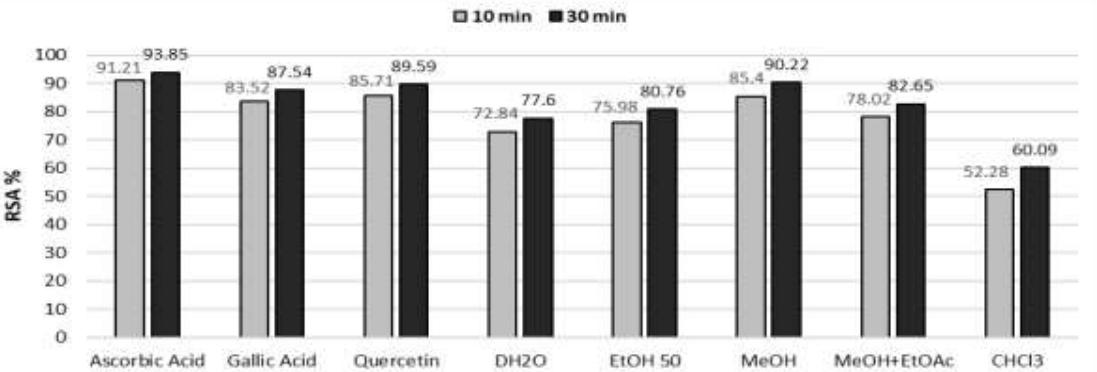
Figure 6. TFC in 1 g of the dried extracts RSA of the extracts DPPH • assay revealed that the methanolic extract was the most effective in free radicals scavenging after 30 min (90.22 %), compared with the other extracts: MeOH: EtOAc (1:1), EtOH 50%, DH 2 O and CHCl 3 , they scavenge 82.65, 80.76, 77.6 and 60.09 % of DPPH • radical, and the scavenging activity after 10 and 30 min for the standards and studied extracts is shown in Figure (7).